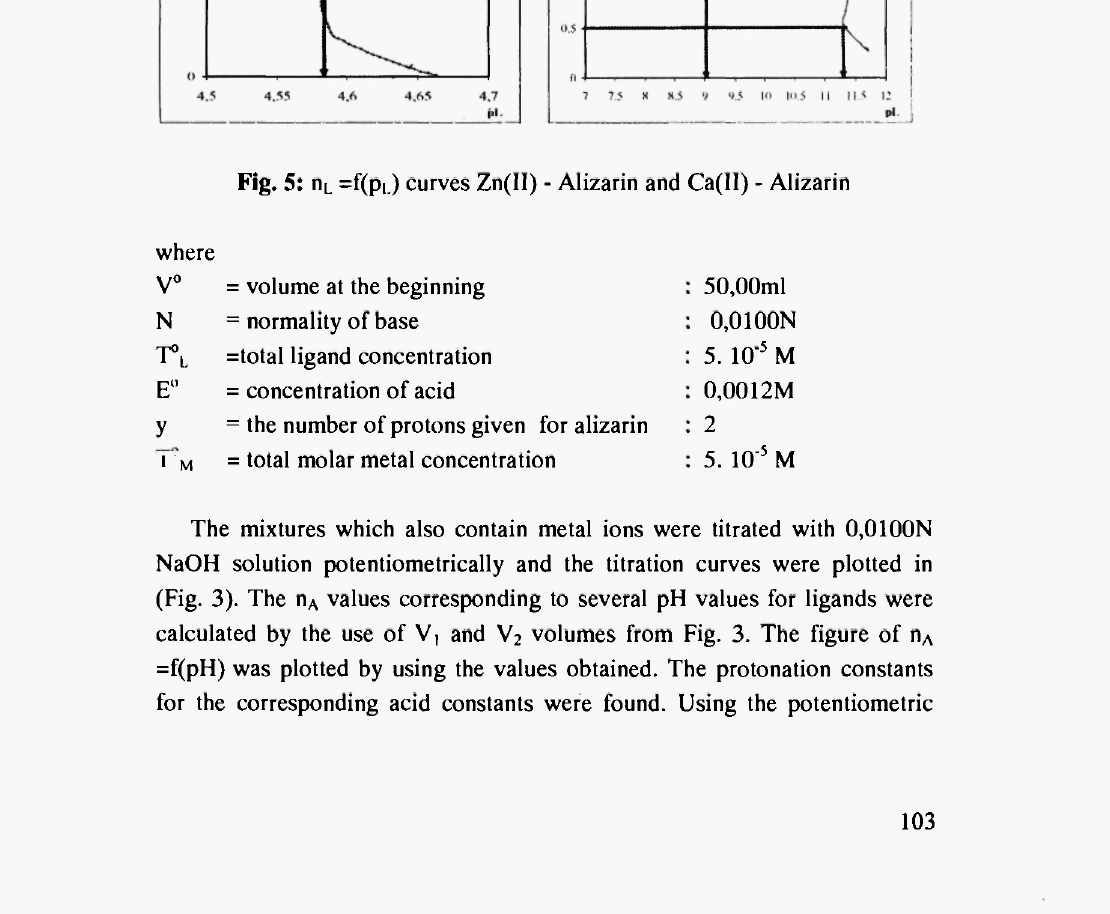
Fig. 4: pH -n A curve for Alizarin